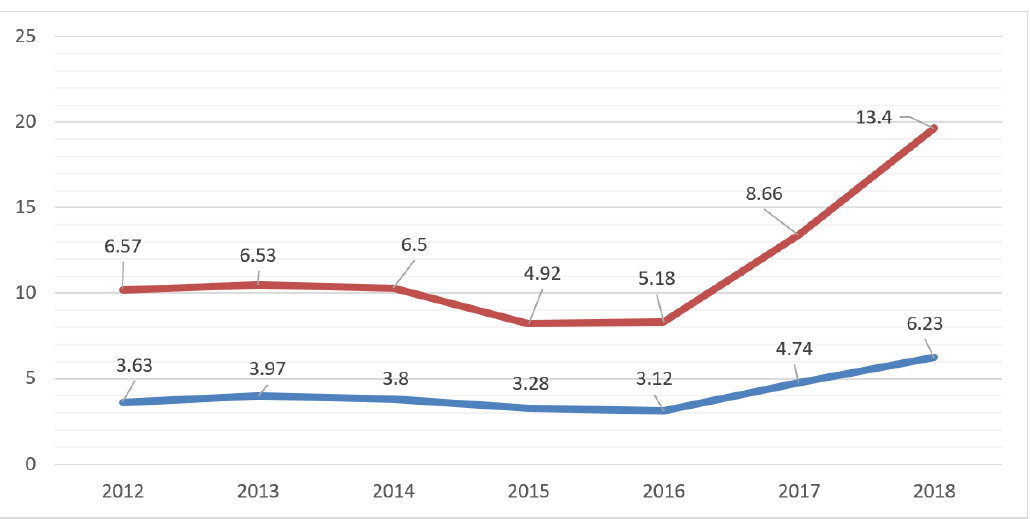
Figure 1. Hard coal import to Poland in the years 2012–2018 (in millions onnes). Source: Authors study based on Eurostat databases (Red: Import for Russia; Blue: Import from other destinations).